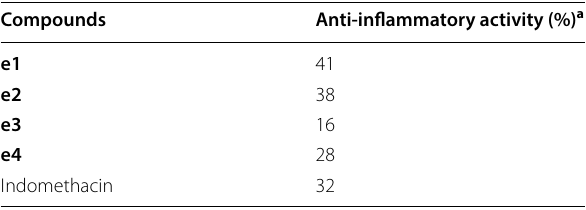
Table 37 Anti-inflammatory activity in percentage (%) of synthesized compounds (e1–e4)